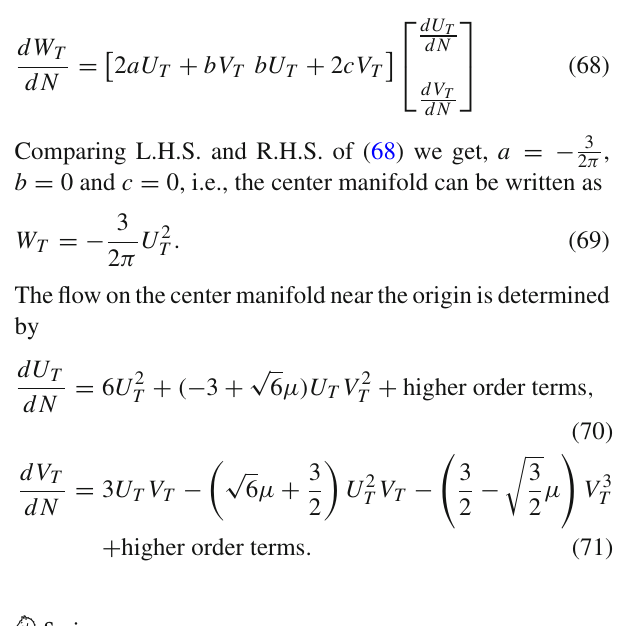
of the second equation of Appendix B vanishes. The vector field in V W plane near the origin for μ = in Fig. 10. Case 2: α (cid:8)= 3 After shifting the critical point P 5 to the origin, the cal- culation change the system of equations (22–24) due to this coordinate transformation is shown as in Appendix